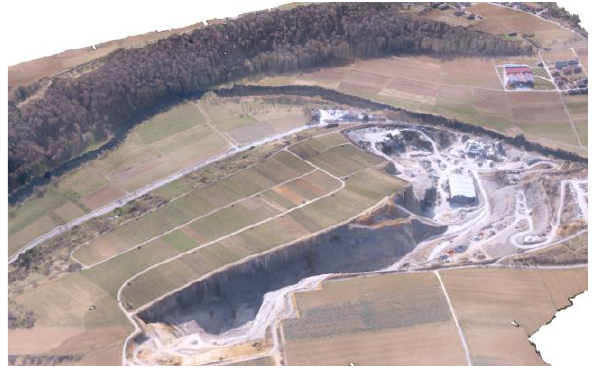
Figure 11: Perspective view of UAV ortho image draped over computed